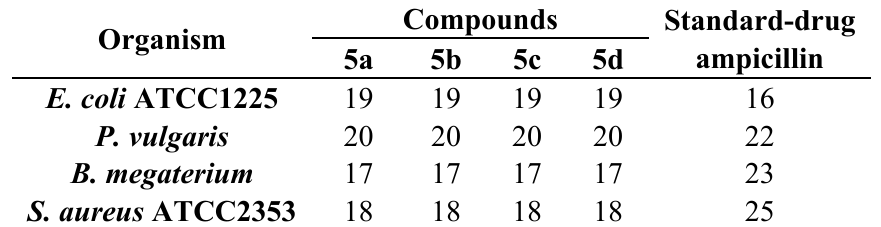
Table 6. Antibacterial activity against bacteria of 5a – d , inhibition zone expressed in